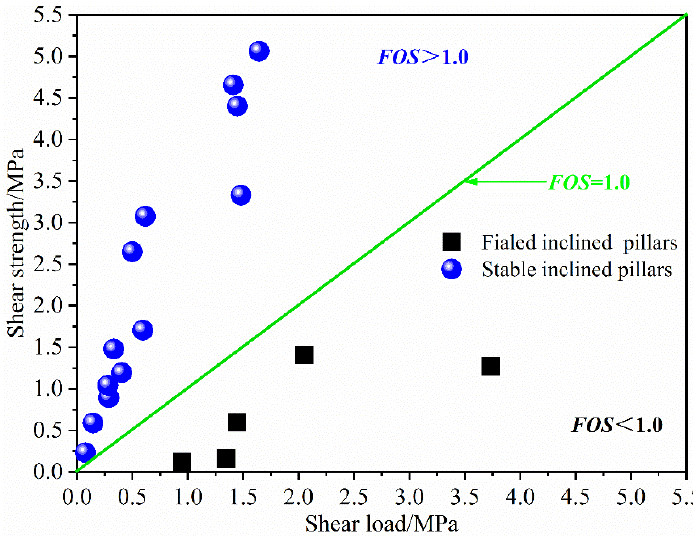
Figure 9. Shear load vs. shear strength of failed and stable inclined pillar